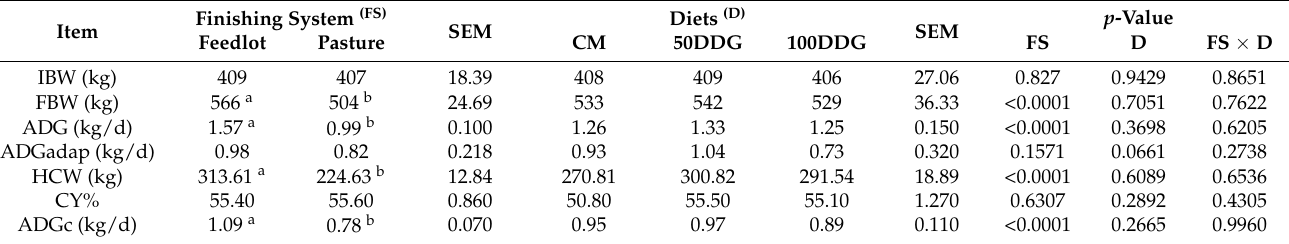
Table 6. Beef cattle performance in two finishing systems: feedlot and pasture.